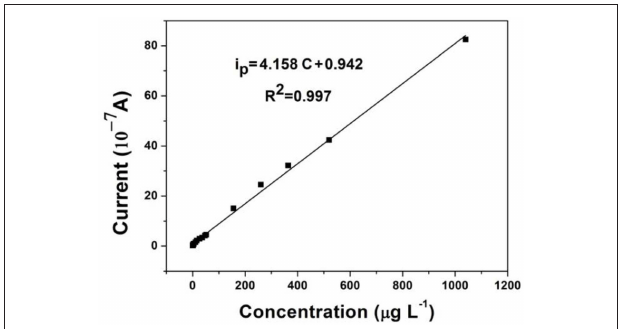
FIGURE 5 | Calibration curve of Cr(VI) on the AuNPs/Nano-TiC/GCE in pH = 2 HCl.